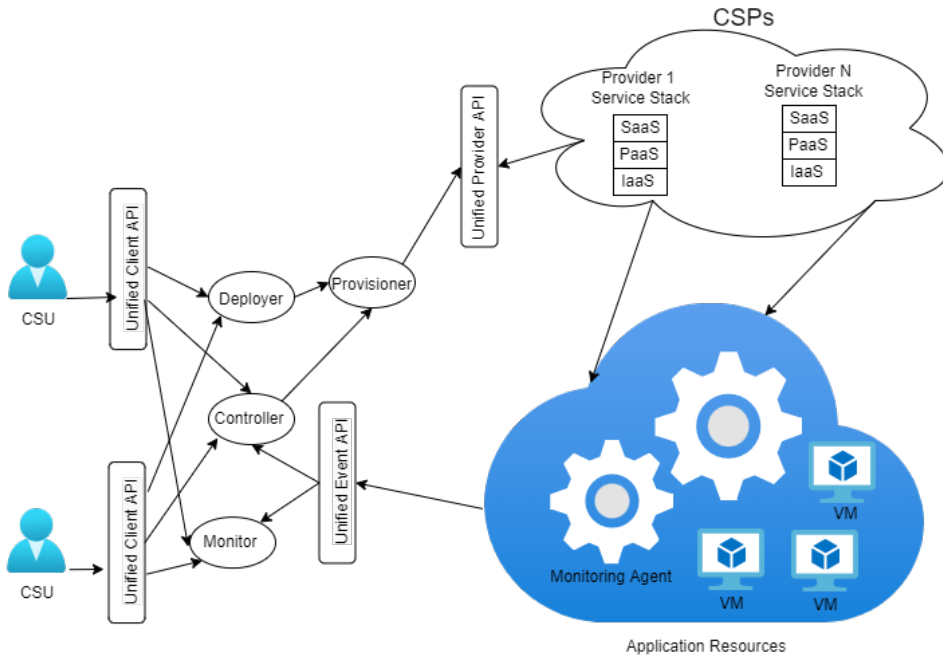
Figure 1. Resource provisioning framework in the public